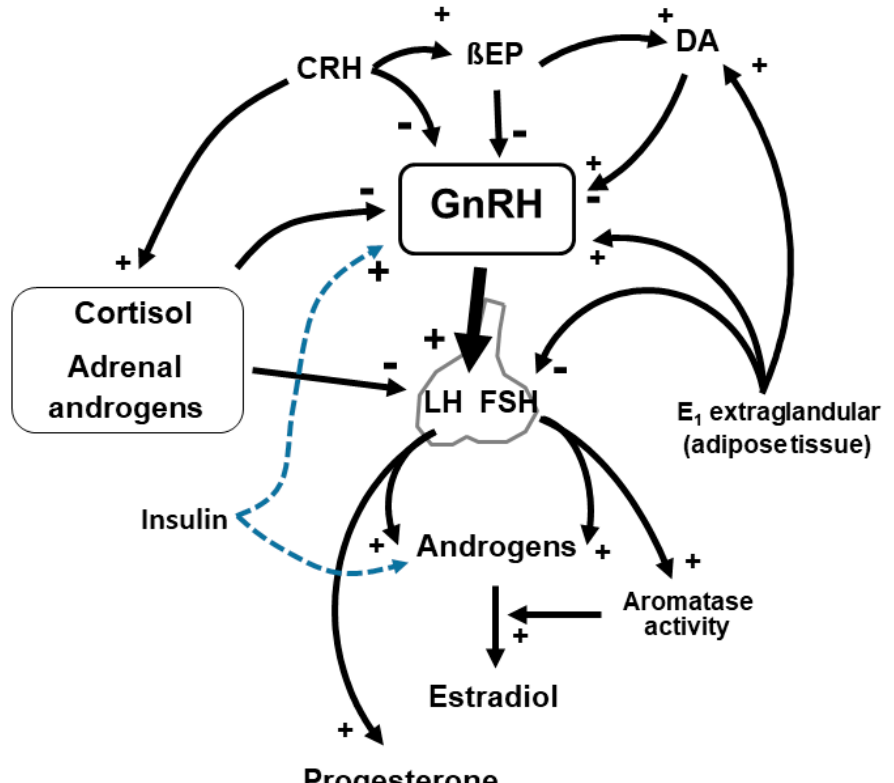
Figure 1. GnRH-secreting neurons undergo to a number of modulations, positive and negative. Stress, through CRH activation, determines a slowing down of GnRH secretion together with opioid peptides ( β endorphin, BEP). Similarly, adrenal gland hormones play a negative role on hypothalamic and hypophyseal function. Insulin, especially in hyperinsulinemic PCOS patients, stimulates ovarian androgens synthesis and LH release, thus improving the ovarian impairment. DA: dopamine, CRH: corticotrophin-releasing hormone, E1: estrone, β EP: beta endorphin.